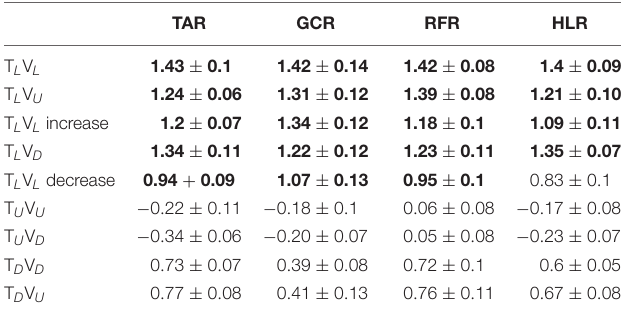
TABLE 2 | Averaged normalized correlation coefficients of the muscle activation pattern between pre- and post-transition across all participants ( N = 12). TAR GCR RFR